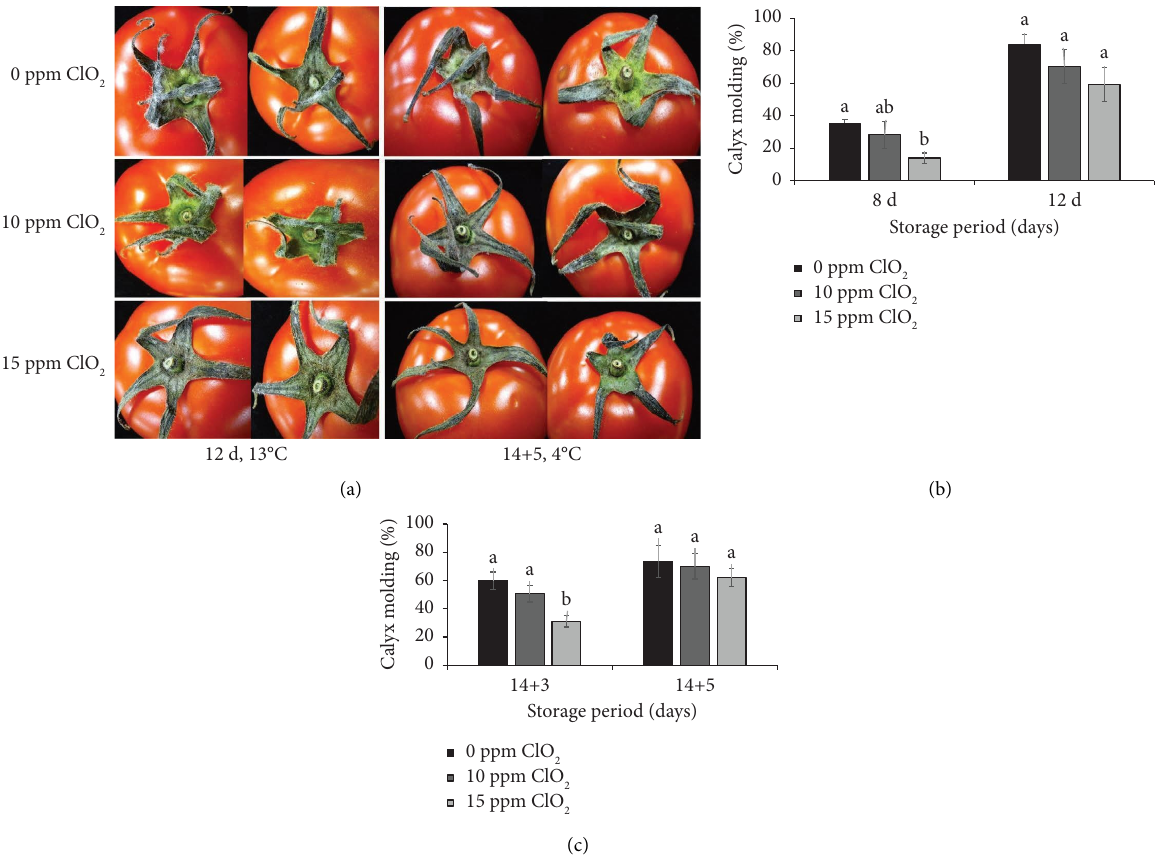
Figure 2: Efect of ClO 2 treatment on calyx molding in tomato. (a) Representative images of tomatoes with diferential calyx molding after various treatments and storage conditions. (b) Calyx molding in tomatoes stored at 13 ° C and (c) 4 ° C for 14 days followed by 5 days at 20 ° C. Graphs plotted represent mean values ± standard error (SE) of three replicated measurements. Diferent lowercase letters in the graph indicate statistically signifcant diferences at P < 0 . 05.